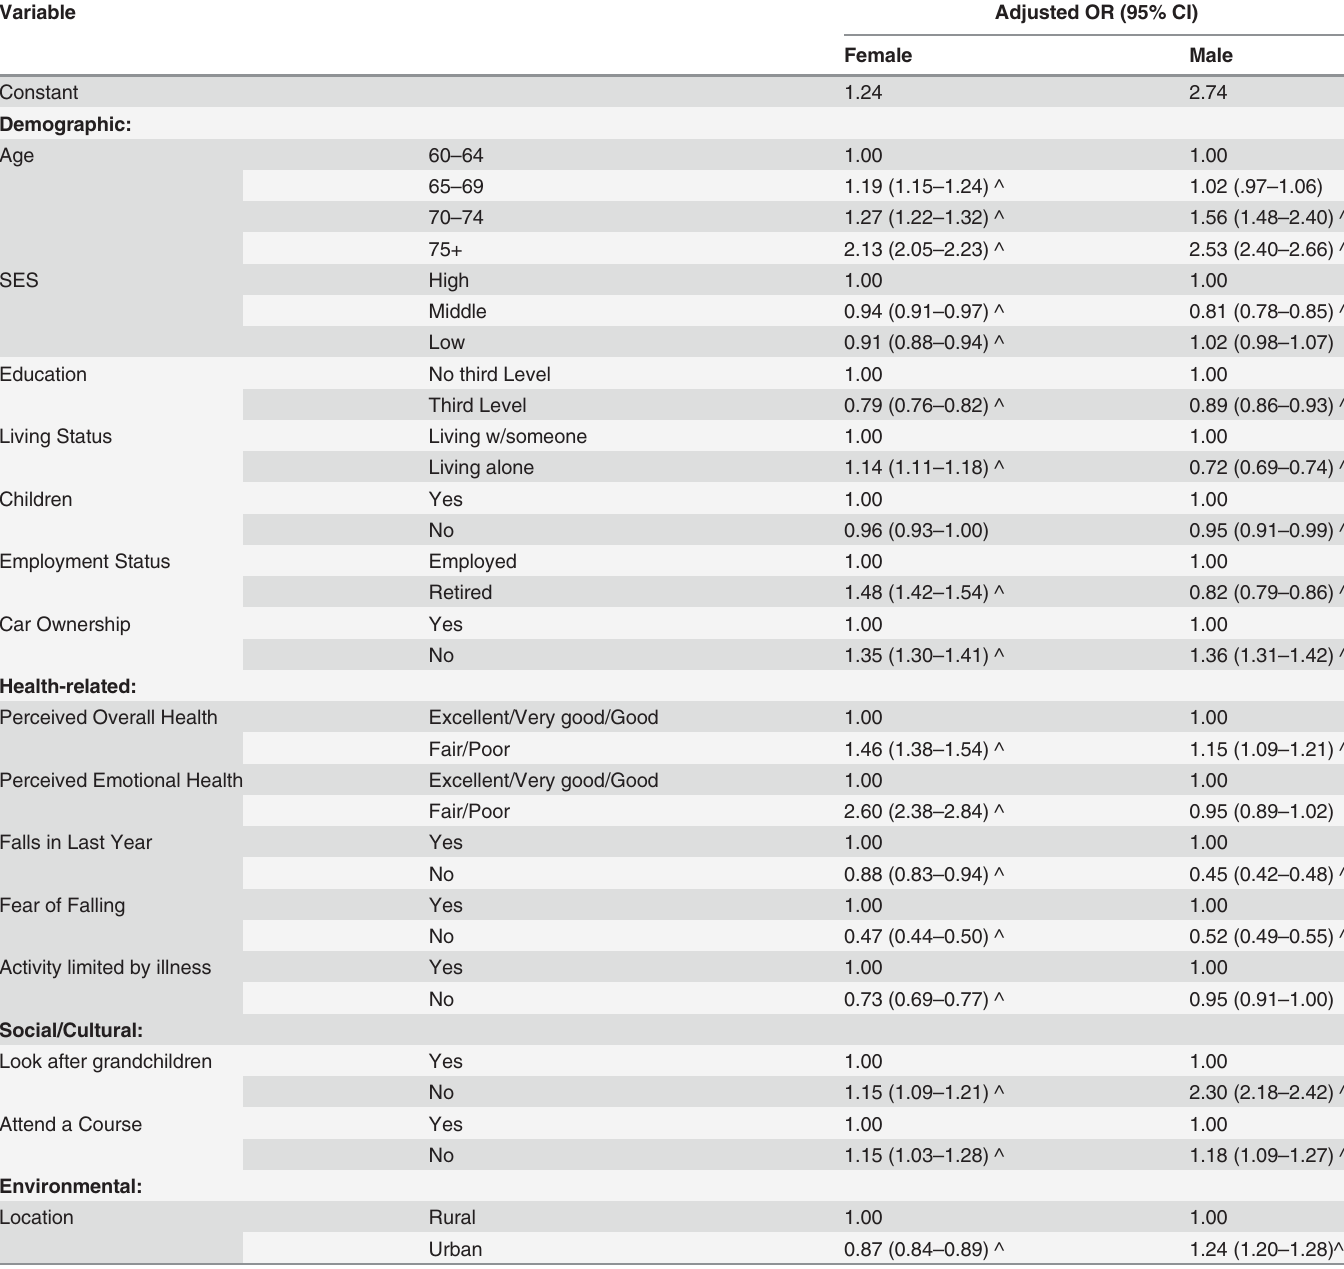
Table 3. Odds Ratio (OR) of physical inactivity by demographic, health-related and environmental variables with gender interactions.